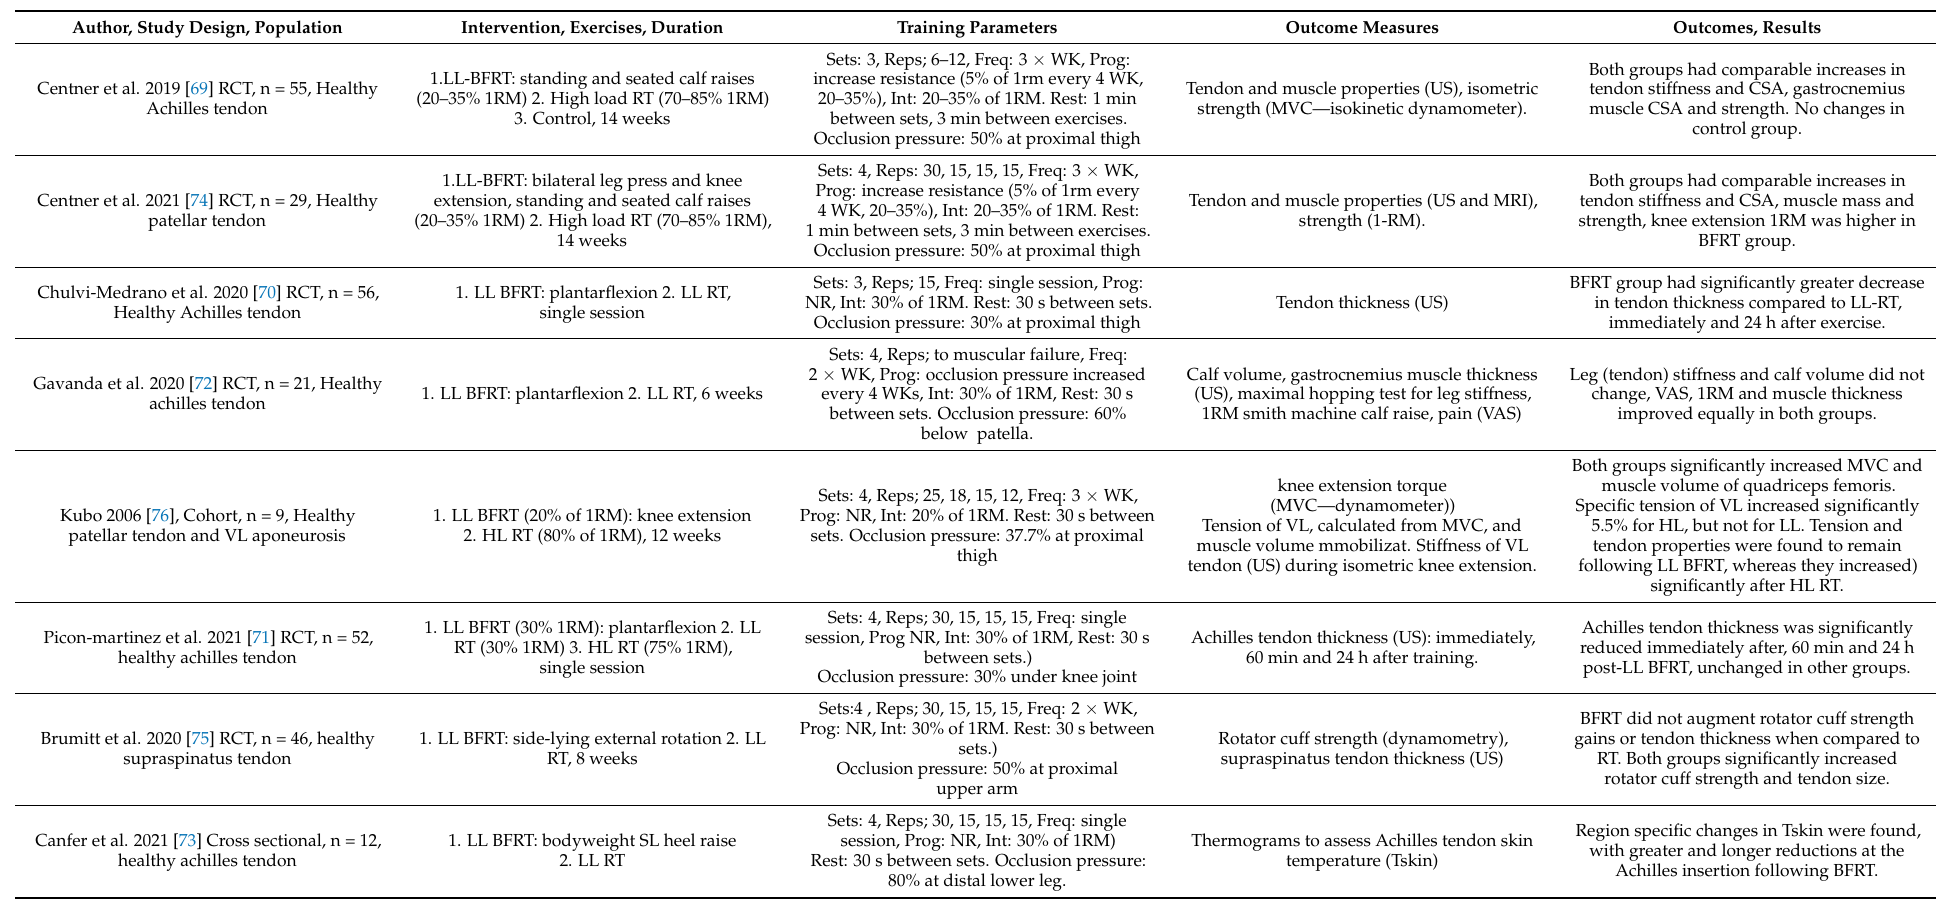
Table 2. Studies on BFRT in healthy